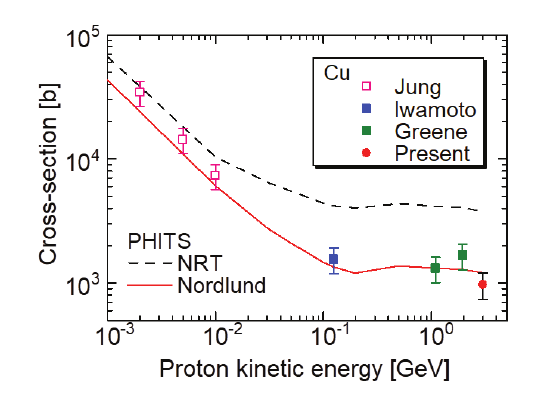
Figure 3. Comparison of the present experiment data with the previous experiment[7, 8, 15] and calculation results with PHITS as a function of kinetic